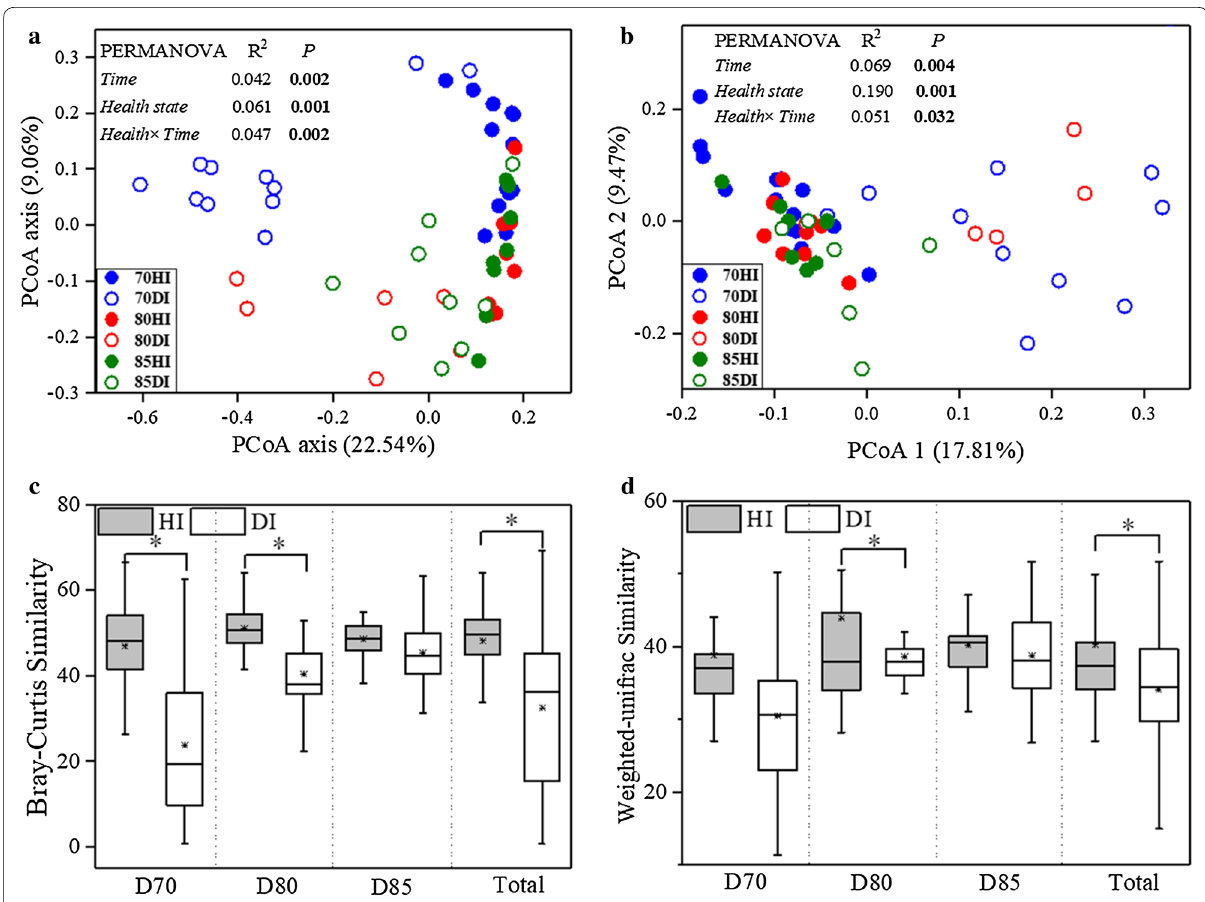
Fig. 2 Principal coordinate analysis (PCoA) plots of community dissimilarities based on Bray–Curtis ( a ) and weighed Unifrac distance ( b ) between healthy and diseased shrimp gut across three sampling days. Sampling days exhibited with distinct colors (Blue: Day 70; Red: Day 80; Green: Day 85) and health state showed with the solid (Healthy) and hollow (Diseased). Permutational Multivariate Analysis of Variance (PERMANOVA) was used to test the significance of time, health state and their interaction in community variation at each day. Box plots of healthy and diseased gut bacterial communities based on Bray–Curtis ( c ) and weighed Unifrac ( d ) similarity within each and all sampling day. HI healthy gut; DI diseased gut. Significant differences were indicated by the asterisk (*P < 0.05) based on one-way analysis of variance. Lines at the top, bottom, and middle of the box correspond to the 75th, 25th, and 50th percentiles (median), respectively. The asterisk in the box represents the mean